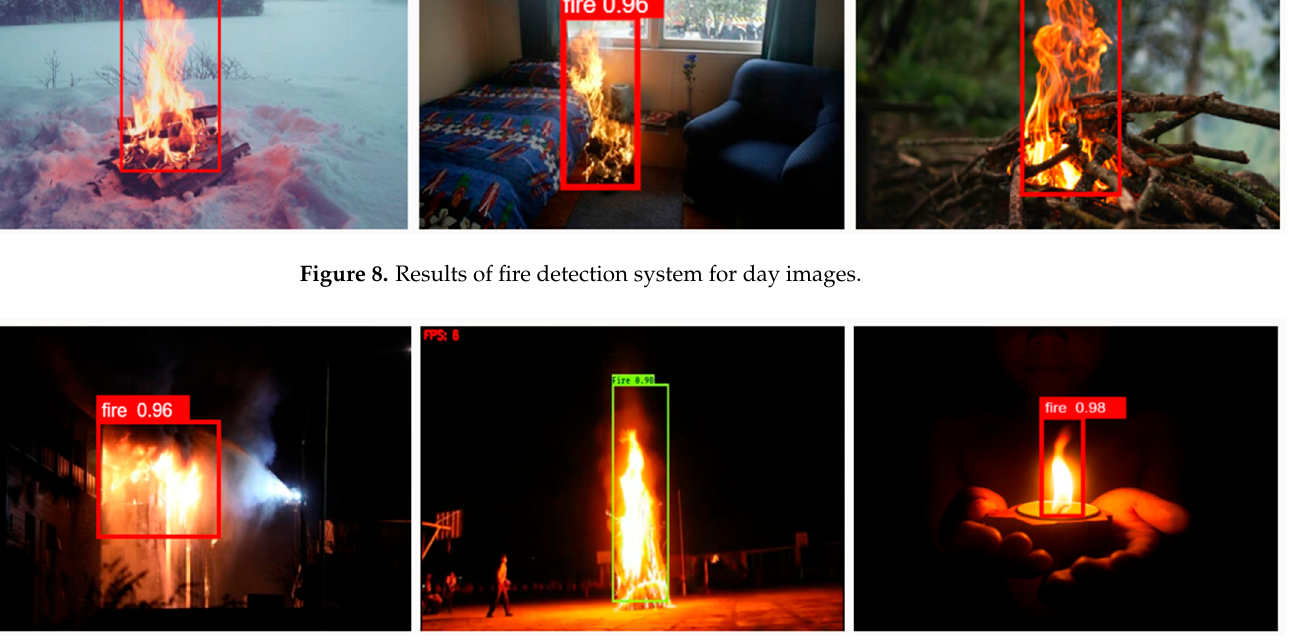
Figure 9. Results of fi re detection system for night images.